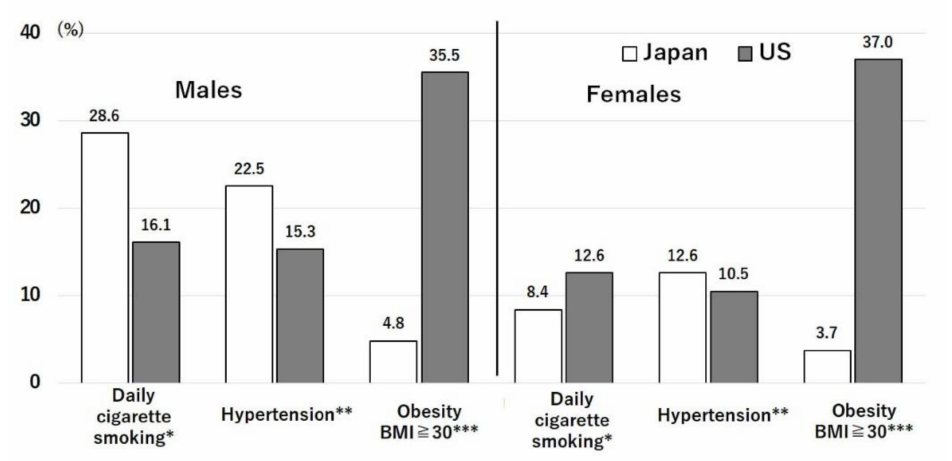
Figure 3. Prevalence of risk factors for non-communicable diseases in Japan and the U.S. Data ob- tained from the WHO Global Health Observatory data repository, World Health Organization